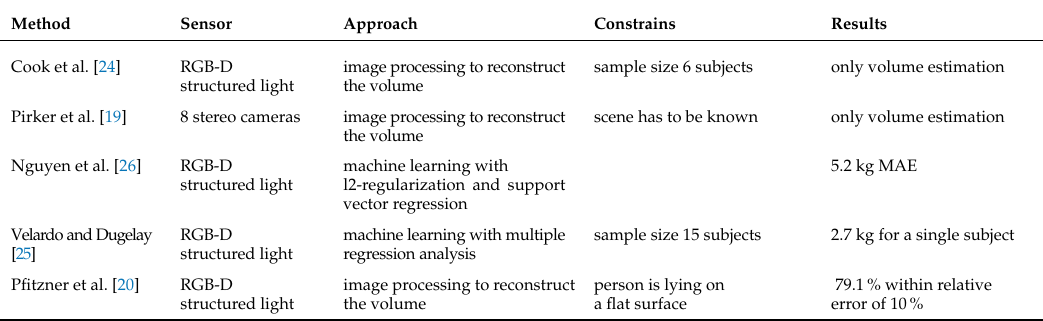
Table 1. Results for contact-less human body weight estimation from related work in alphabetic order. The results are not directly comparable due to different evaluation